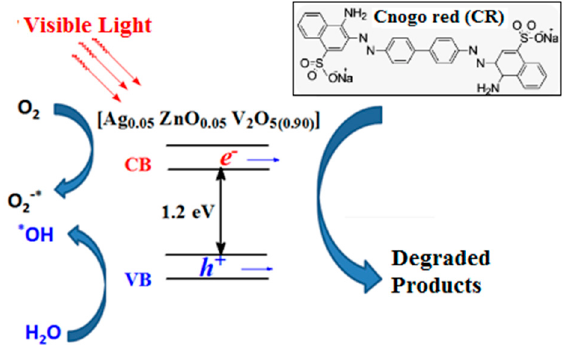
Figure 12. The proposed mechanism of CR degradation over [Ag 0.05 ZnO 0.05 V 2 O 5(0.90) ] photocatalyst under visible-light irradiation.